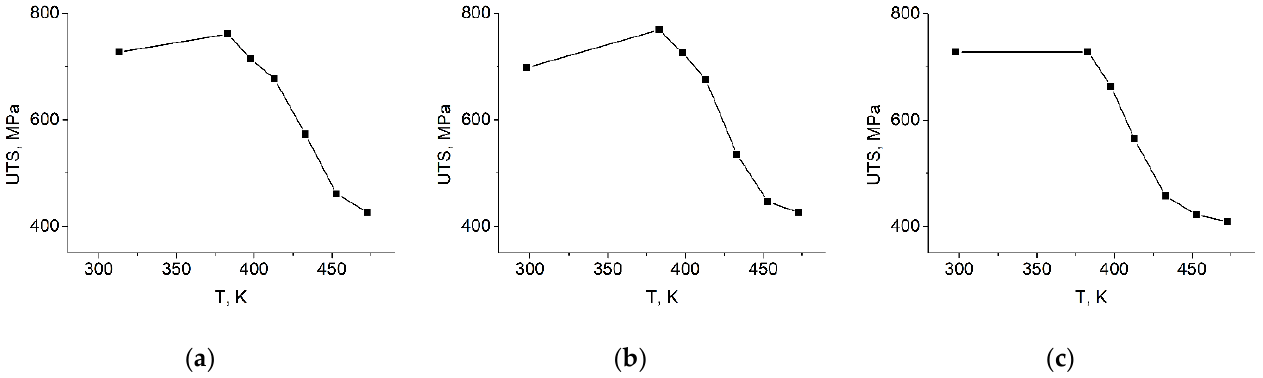
Figure 7. Ultimate tensile strength values of the steel specimens tensile tested at different temperatures. ( a ) Steel 0.07, ( b ) Steel 2.26, ( c ) Steel 6.12.